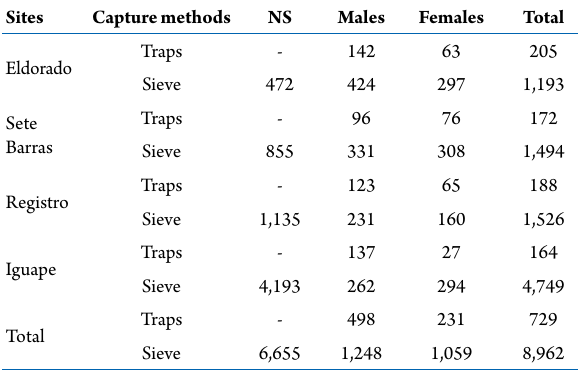
Table 1. Absolute abundance of Macrobrachium olfersii per site and capture method (NS= undifferentiated).